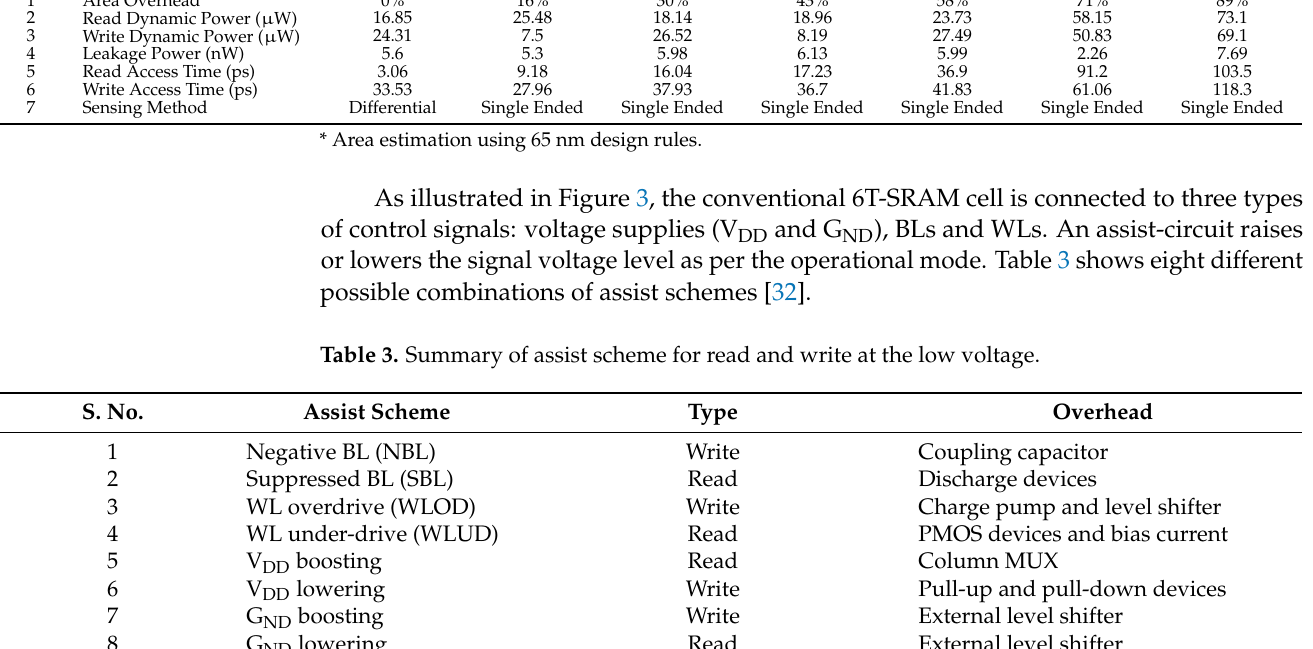
Table 2. Performance analysis of 6T-12T SRAM cells. (Simulation in 65 nm CMOS at nominal voltage).